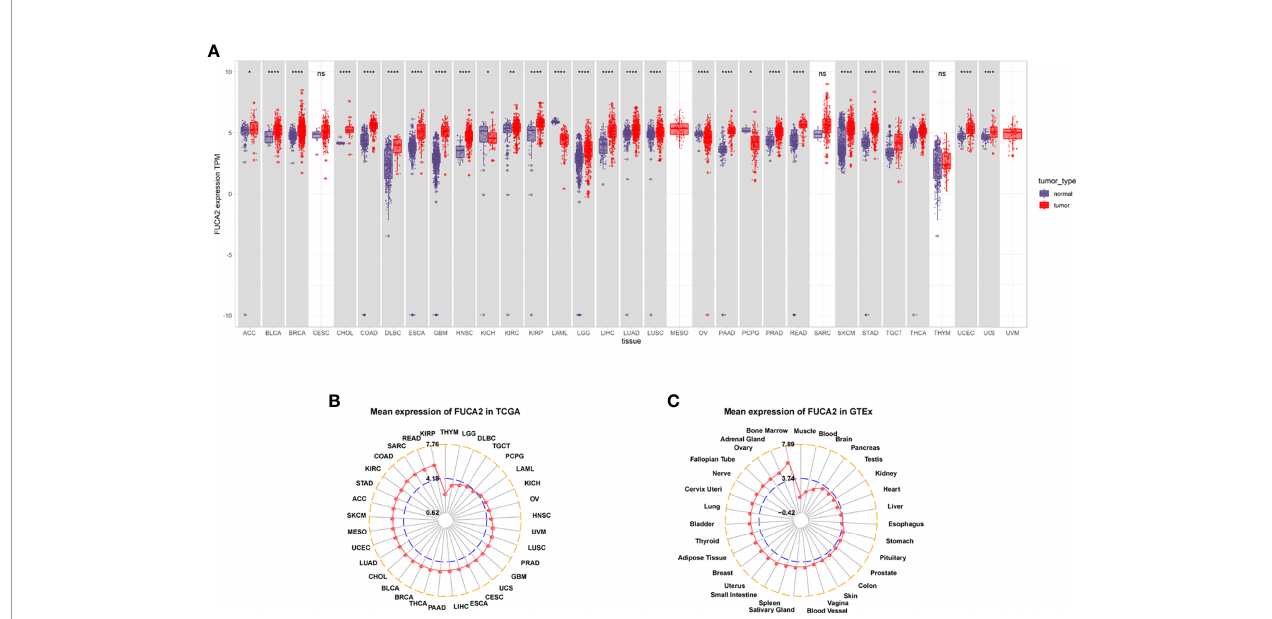
FIGURE 1 | FUCA2 levels varies across tumors. (A) Patterns of FUCA2 level between tumor and normal tissues. (B) Pro fi les of FUCA2 expression in 33 cancer types. (C) Expression of FUCA2 in normal tissues. *P < 0.05, **P < 0.01, ****P <